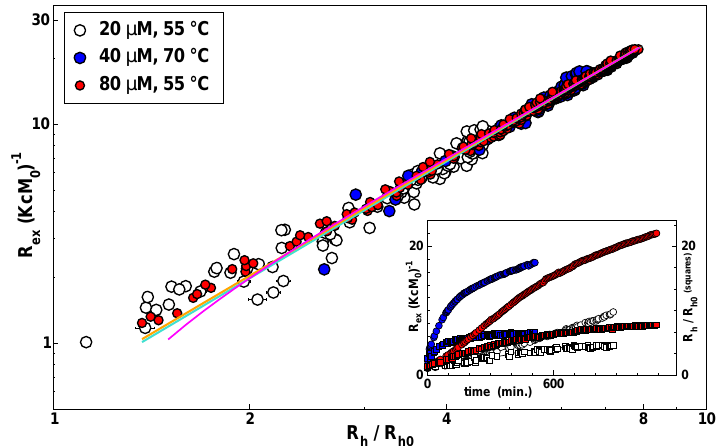
Figure 5. Normalised Rayleigh ratio, R ex ( KcM 0 ) − 1 , vs. hydrodynamic radius, R h , of M α 1 AT incubated at different temperatures and concentrations, as shown in the legend. Inset: polymerisation kinetics monitored over time in terms of M w (circles) and R h (squares). The orange solid line represents a power law with exponent 1.75. The green solid line represents a fit by using scaling expressions as described in the text. The magenta solid line represents a curve drawn by using WLC expressions as described in the